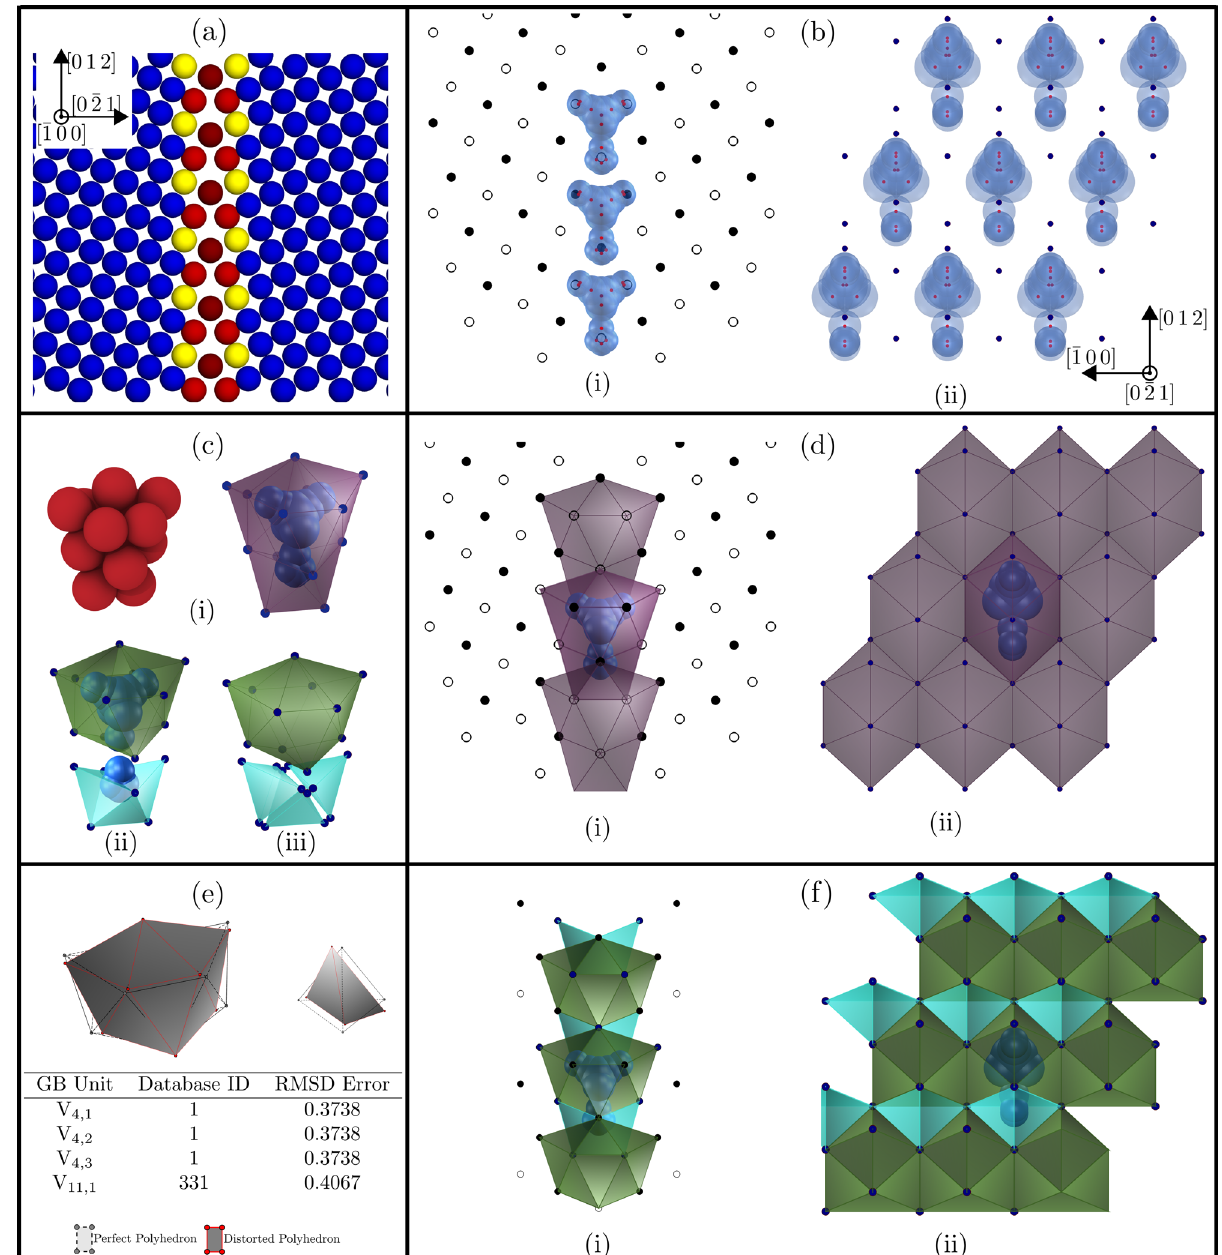
Fig. 2 An illustration of the VV-clustering algorithm for identifying the polyhedral unit structure of the Σ 5 ð 021 Þ GB. a The minimum energy atomistic structure (at 0 K) of the GB, generated using OVITO, 59 is shown along the tilt axis ½ 100 (cid:5) , where the atoms are colored according to their centro-symmetry parameter. b (i, ii) Atomistic structure of the GB along with the Voronoi vertices and VV-spheres are shown, as viewed along the tilt axis ½ 100 (cid:5) and the boundary-plane normal ½ 021 (cid:5) , respectively. All the Voronoi vertices of overlapping VV-spheres are clustered together and, in c (i) The polyhedral unit obtained by the clustering algorithm is shown. The polyhedron contains thirteen atoms. In d (i, ii), the polyhedral unit model of the Σ 5 ð 021 Þ along the tilt axis ½ 100 (cid:5) and the boundary-plane normal ½ 021 (cid:5) , respectively, are shown. Since the polyhedral unit is concave and contains more than 12 atoms, it is fi rst split into smaller units by fi nding the interstitial voids of the 13-atom unit as shown in c (ii). The split units are then compared with the Cerfon-Holmes database and the iterative cluster (poly-tetrahedral unit) is split further into three tetrahedral units, as shown in c (iii). e The matching between the 11-atom and the best-match seed (octadecahedron) is shown. The registration between the highest-distorted tetrahedron and the perfect tetrahedron is also illustrated. The RMSD errors for all the resultant units in the GB are shown in the table. Finally, in f (i, ii), the structure of the GB, represented using the split units (octadecahedra and tetrahedra), is